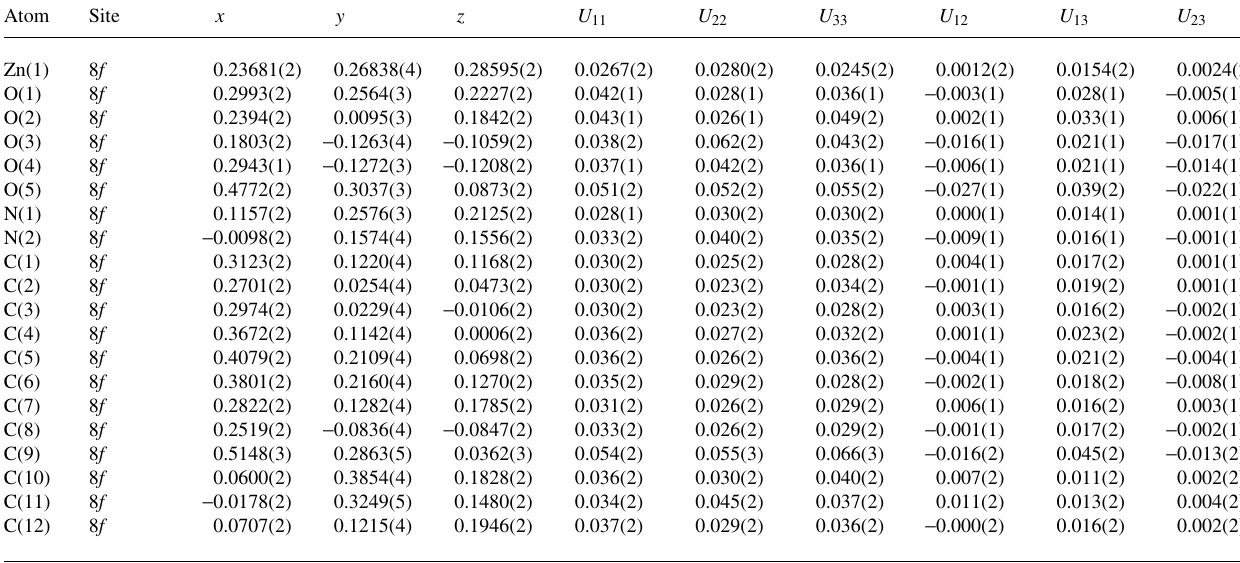
Table 3. Atomic coordinates and displacement parameters (in Å 2 ) .